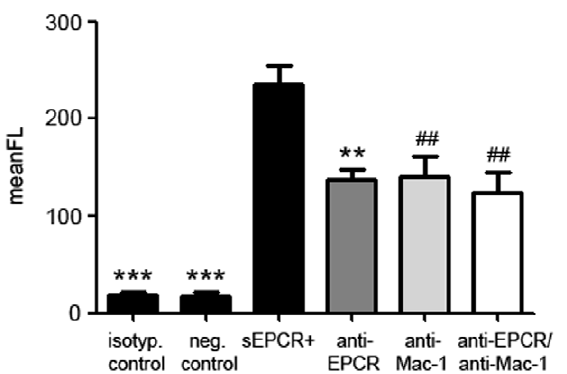
Figure 2. Blockade of sEPCR binding to monocytes by anti- EPCR and anti-Mac-1 in flow cytometry. Binding of soluble, recombinant EPCR to monocytes (black bar second from left) can be blocked by anti-EPCR (dark grey bar), by anti-Mac-1 (light grey bar) and by both antibodies (white bar) to an equal extend. Monocytes without addition of sEPCR and isotype IgG served as negative controls (black bars on the left and second from left). (*** p , 0.0001; ** p , 0.001; ## p , 0.005 vs. sEPCR +